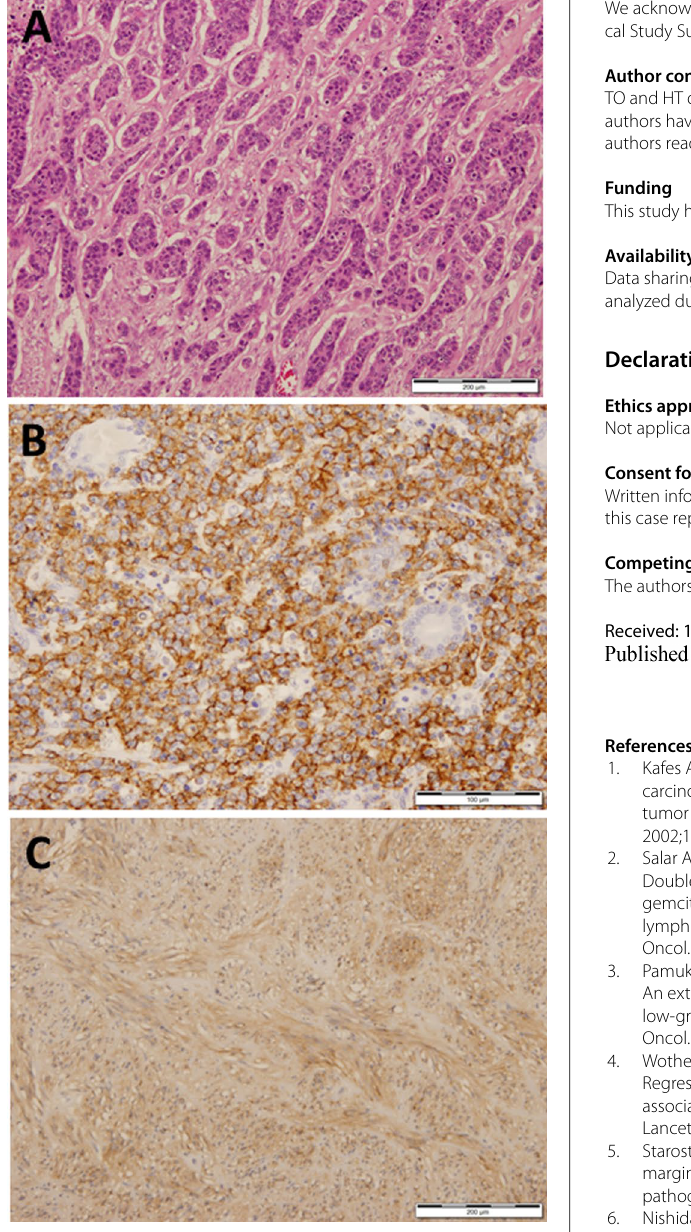
Fig. 4 Histological findings. A Poorly differentiated adenocarcinoma infiltrating into deep submucosa (hematoxylin–eosin: Diffuse large B cell lymphoma tissue containing large atypical lymphocytes immunostaining for CD20 ( stromal tumor tissue containing with spindle, sharp and atypical